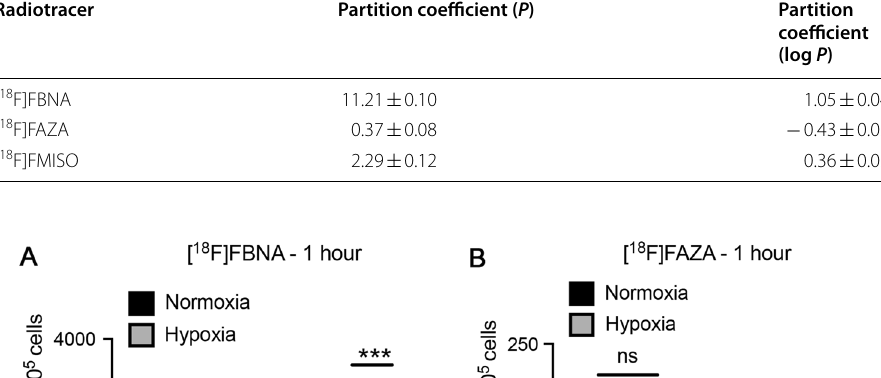
Table 1 Partition coefficient of [ 18 F]FBNA. Compared with [ 18 F]FAZA and [ 18 F]FMISO Radiotracer